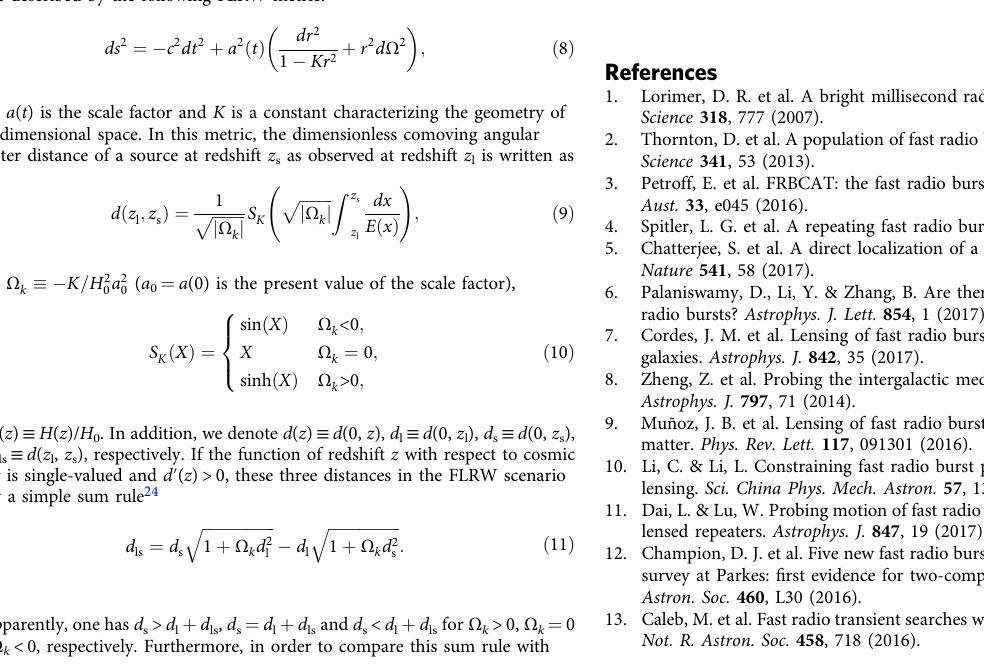
ray tracing through the Millennium Simulation 50 , it was found that the most robust estimate of κ ext has a median value κ med ext ¼ 0 : 004 and a standard deviation σ κ = 0.025, which corresponds to a 2.5% uncertainty on the time-delay distance 51 . More recently, using deep r -band images from Subaru-Suprime-Cam and an inpainting technique and Multi-Scale Entropy fi ltering algorithm, a weak gravitational lensing measurement of the external convergence along the LOS to HE 0435-1223 was achieved κ ext ¼ (cid:4) 0 : 012 þ 0 : 020 (cid:4) 0 : 013 , which corresponds to ~1.6% uncertainty on the time-delay distance 52 . Furthermore, the distribution of κ ext is robust to choices of weights, apertures, and fl ux limits, up to an impact of 0.5% on the inferred time- delay distance 53 . Here we assume that for lensed FRB systems, the LOS environment contributes a systematic uncertainty at an averaged 2% level to the inferred time-delay distance, expecting that every lensed FRB system is given enough attention by the community so that we can combine auxiliary follow-up data from facilities at different wavelengths and other available simulations with convergence maps. It is still worth noting that larger LOS systematic uncertainty could lead to larger error bars of cosmological parameters. In addition to the distribution of mass external to the lens, the mass distribution in the outskirt of the lens halo, in which there are little optical light traces, might lead to errors in the inferred time-delay distance at the percent level and it was shown that weak gravitational lensing and simulations may help to reduce these uncertainties 54 . Distance sum rule . According to the cosmological principle, the space of the universe is homogeneous and isotropic at large scales. In this case, the spacetime